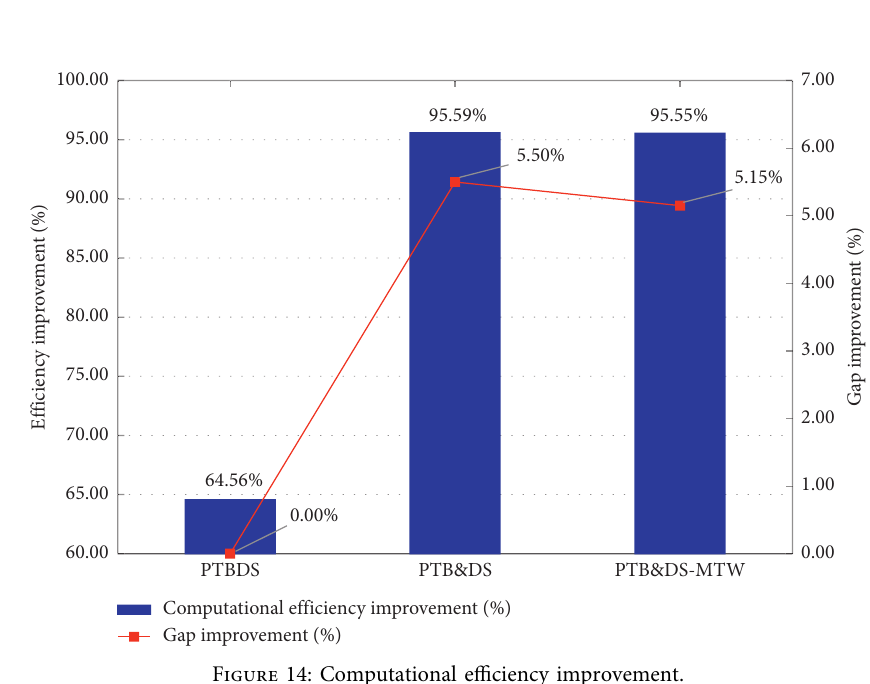
Figure 14: Computational efficiency